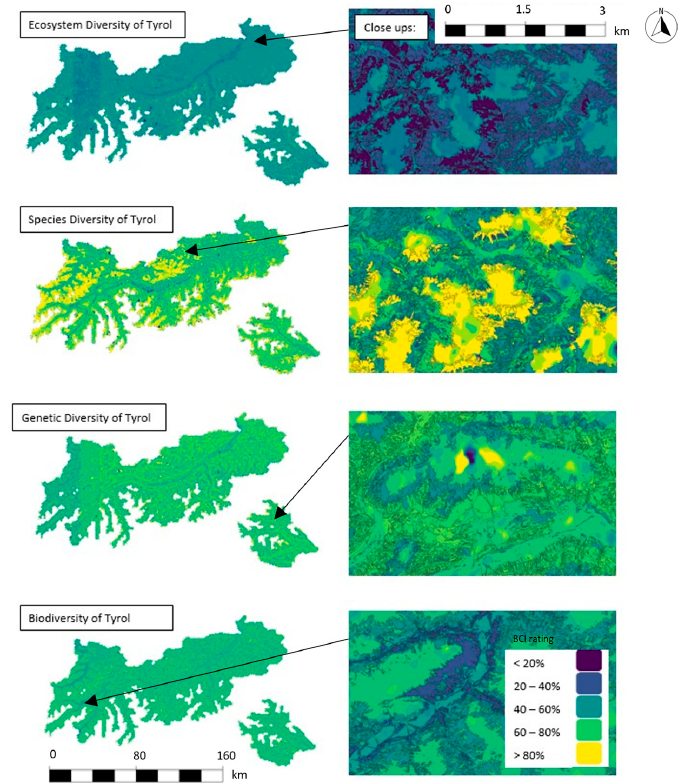
Figure 8. Maps of forest ecosystem, species, genetics, and biodiversity (47°15 ′ 13.468 ″ N, 11°36 ′ 5.353 ″ E). High-resolution maps of forest ecosystem, species, genetics, and biodiversity of Tyrolean forests. Outcomes